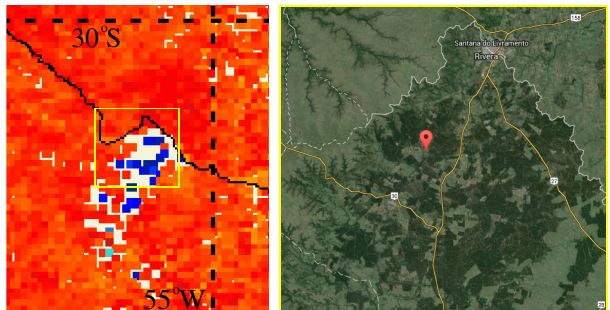
Figure 6. Enlargement of an area at the border of Uruguay and Brazil, where local trends indicate “wetting” (left). The satellite picture (http://maps.google.com) clearly indicates intensive agricul- tural/forestry activity in the region (right).